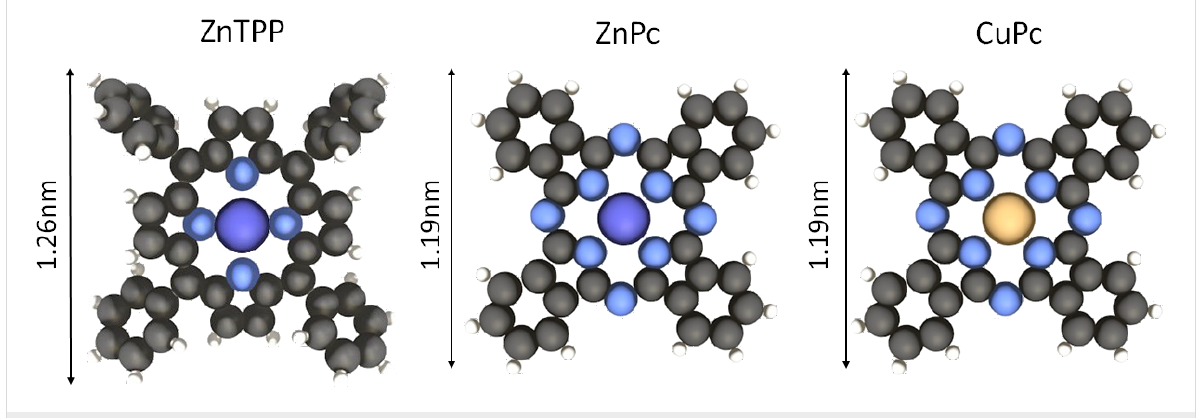
Figure 8: Chemical structure of the molecules used in the study (from left to right): Zn(II) meso -tetraphenylporphyrin (ZnTPP), Zn(II)phthalocyanine (ZnPc), and Cu(II)phthalocyanine (CuPc). Color coding: dark gray (carbon), light gray (hydrogen), blue (nitrogen), large violet (zinc), large yellow